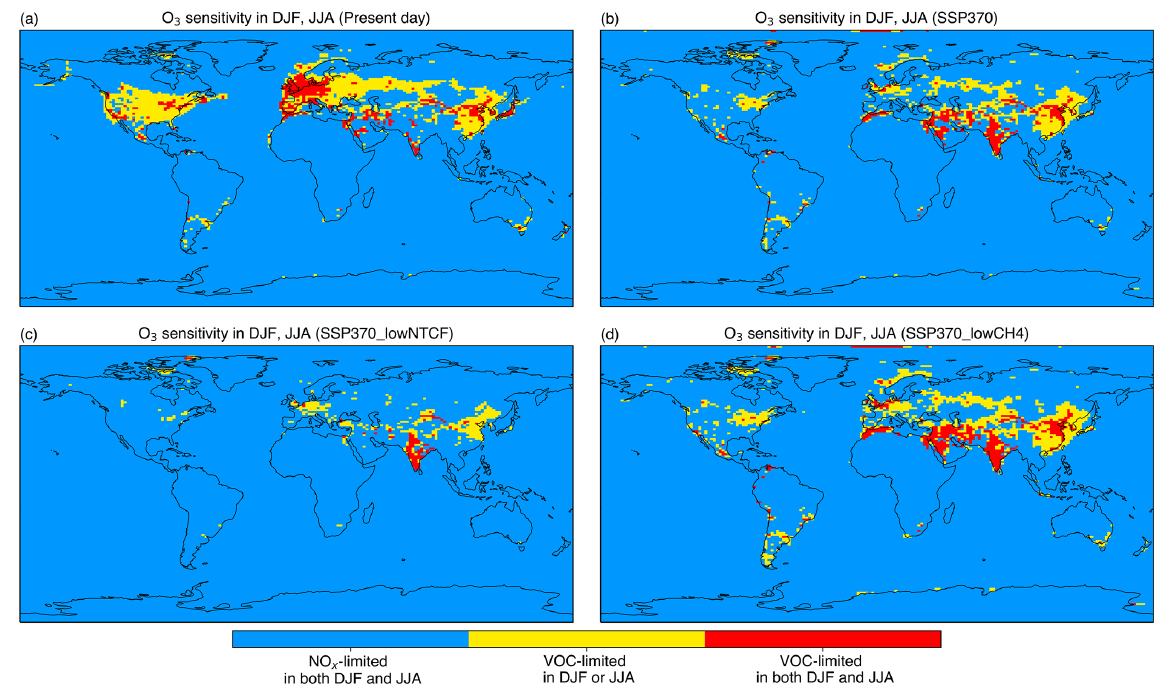
Figure 10. Seasonal differences in O 3 sensitivity regimes for the present day (2004–2014; a ) and under SSP3-7.0 (b) , SSP3-7.0- lowNTCF (c) , and SSP3-7.0-lowCH4 (d) (2045–2055). An NO x / VOC threshold ratio of 0.8 is used here to distinguish O 3 sensitivity